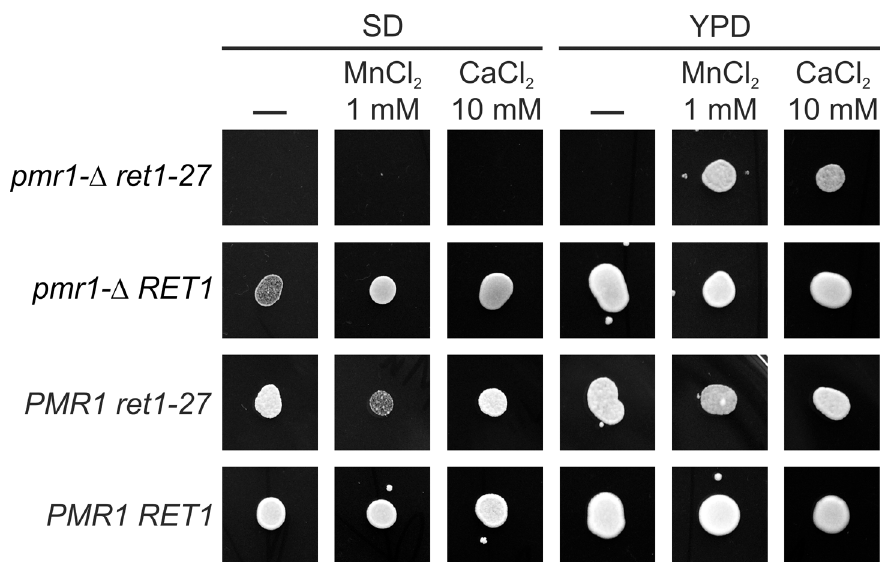
Fig 2. Rescue of growth of the pmr1- Δ ret1-27 double mutant by CaCl 2 and MnCl 2 . Since the ret1-27 pmr1- Δ double mutant was inviable on regular media, it was obtained from the MC39-MOX strain, which carried a PMR1- contaning plasmid. To allow the MC39-MOX and MC39-RET-MOX strains to lose the PMR1 - contaning plasmid, they were streaked on YPD plate supplemented with 10 mM CaCl 2 . Equal amounts of cells from single colonies obtained on this medium were suspended in sterile water and spotted onto test plates. Growth of only one subclone for each case is shown in the figure. Growth of three additional subclones is shown in S4 Fig pmr1- Δ ret1-27 , a MC39-MOX subclone lacking the plasmid; PMR1 ret1-27 , a MC39-MOX subclone retaining the plasmid; pmr1- Δ RET1 , a MC39-RET-MOX subclone lacking the plasmid; PMR1 RET1 , a MC39-RET-MOX subclone retaining the